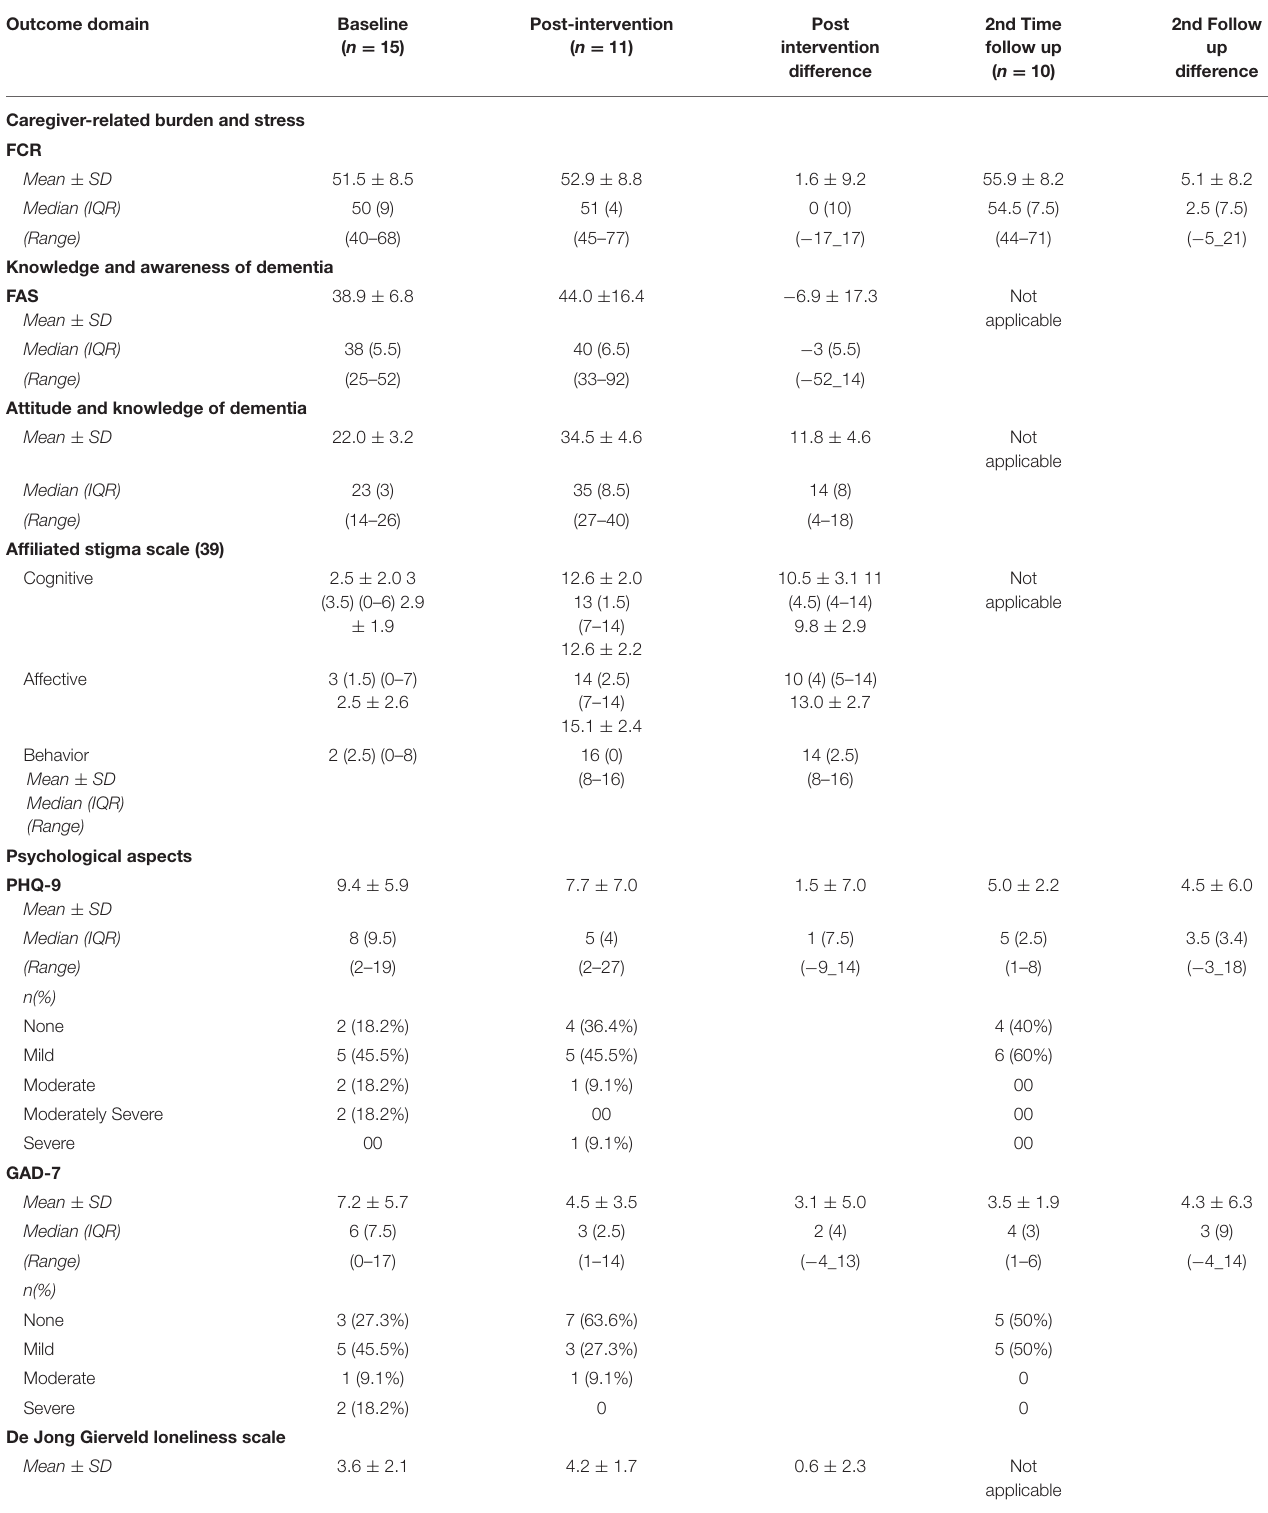
TABLE 7 | Baseline and post-intervention outcome measurements for the